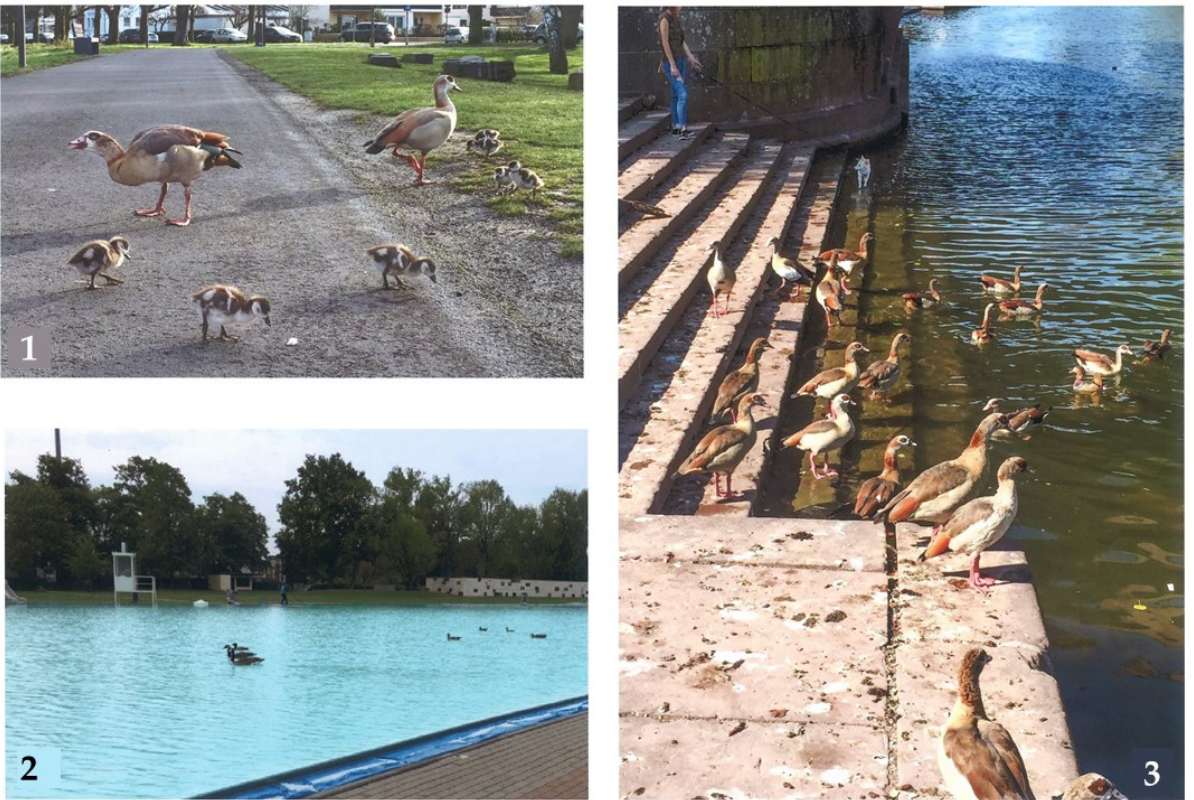
Figure 1. Egyptian geese ( Alopochen aegyptiaca ) in urban habitats: ( 1 ) both parental birds guiding ducklings in an urban park; ( 2 ) Egyptian geese together with Canada geese ( Branta canadensis ) and Mallards ( Anas platyrhynchos ) in an urban public pool; and ( 3 ) group of subadult Egyptian geese in a urban resting site contaminated with droppings.